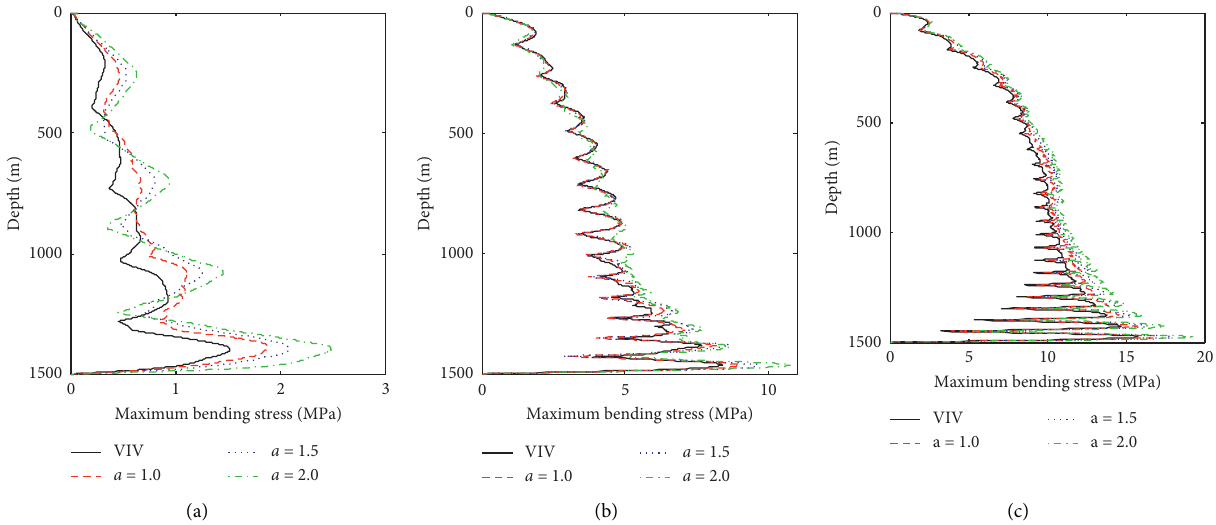
): (a) U 0 � 0.2m/s; (b) U 0 � 0.5m/s; (c) U 0 � 4